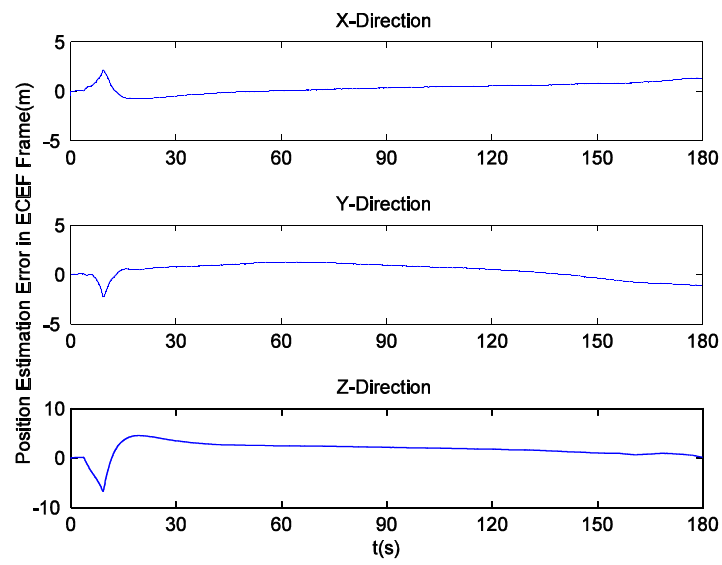
Figure 20. GPS/INS (tight integration, traditional navigation filter) position estimation errors.